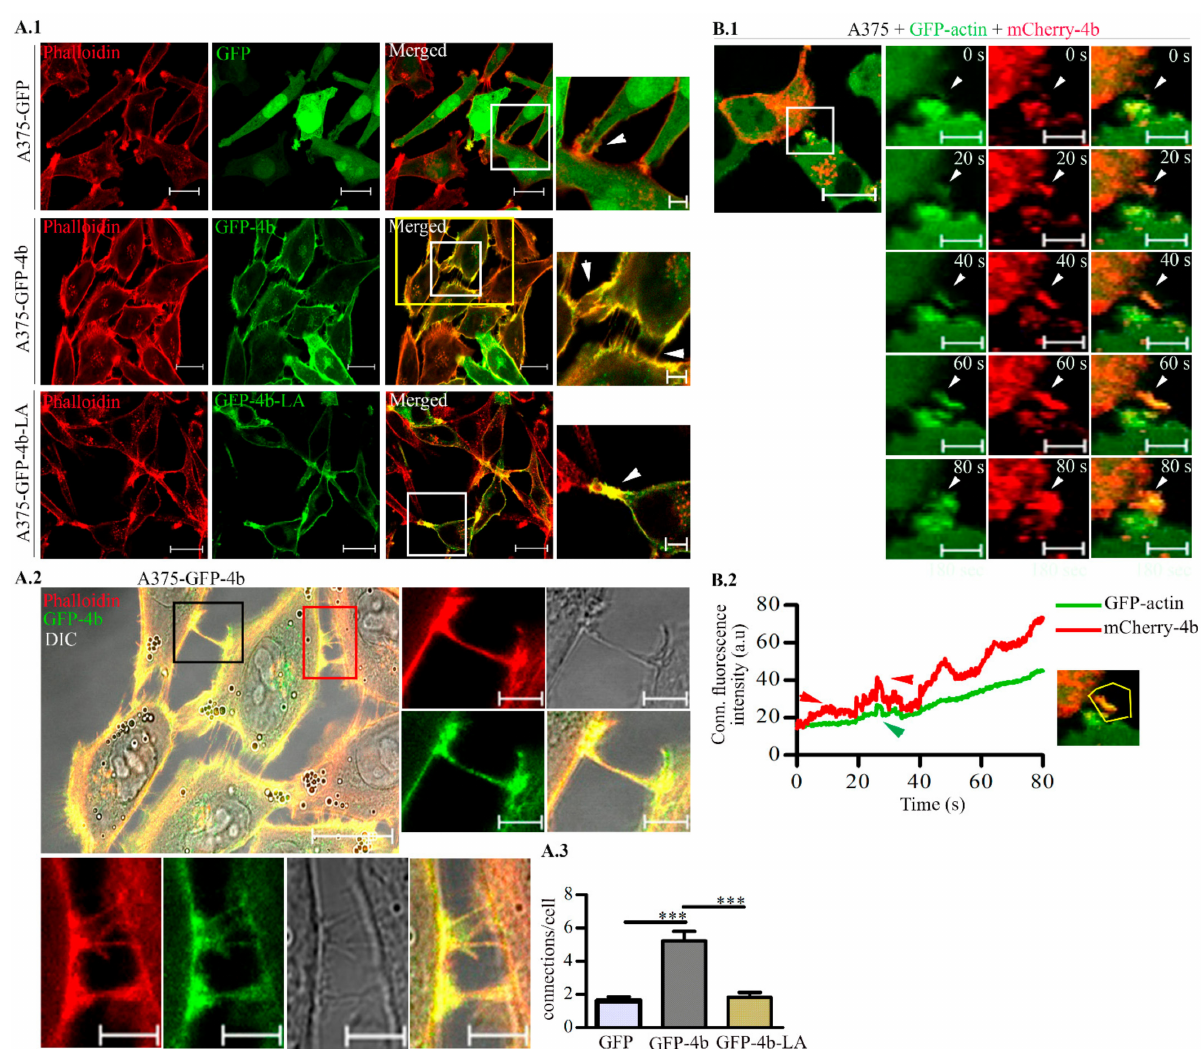
Figure 2. PMCA4b but not the trafficking mutant PMCA4b-LA increased cell–cell connections between A375 cells. ( A.1 ) Con- focal microscopy images of A375-GFP, A375-GFP-PMCA4b, and A375-GFP-PMCA4b-LA cells labeled with Phalloidin- TRITC. Scale bar, 20 µ m. Insets show images with higher magnification of field marked with white rectangles; arrowhead indicate cell–cell connection. Scale bar, 5 µ m. ( A.2 ) High magnification DIC and fluorescence images of A375-GFP-PMCA4b cells are taken from the field marked with the yellow rectangle in ( A.1 ). Scale bar, 20 µ m. The black and red insets show images for the intercellular connections formed between cells. Scale bar, 5 µ m ( A.3 ) The graph represents the mean number of connections/cell for 12–13 cell. ( B.1 ) Live cell imaging of A375 cells transiently expressing GFP-actin and mCherry- PMCA4b recorded by spinning-disc confocal microscopy. GFP and mCherry signals were recorded every 0.2 s for 180 s at 37 ◦ C. Scale bar, 20 µ m. Insets show the formation of connection between two cells with higher magnification at different times. Scale bar, 5 µ m. ( B.2 ) The graph depicts the time courses of GFP-actin and mCherry-PMCA4b signals determined in the region of interest (ROI) drawn around a newly forming connection (yellow polygon). Arrowheads indicate the increased signal (*** p <